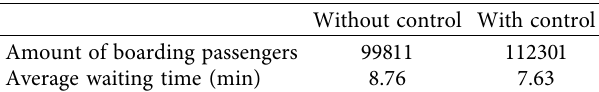
Table 9: Comparison of transported passengers and waiting times.